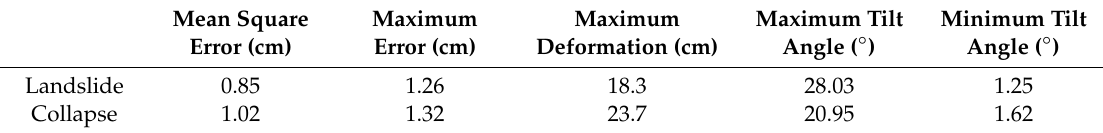
Table 3. Analysis of simulation measurement errors of landslide and